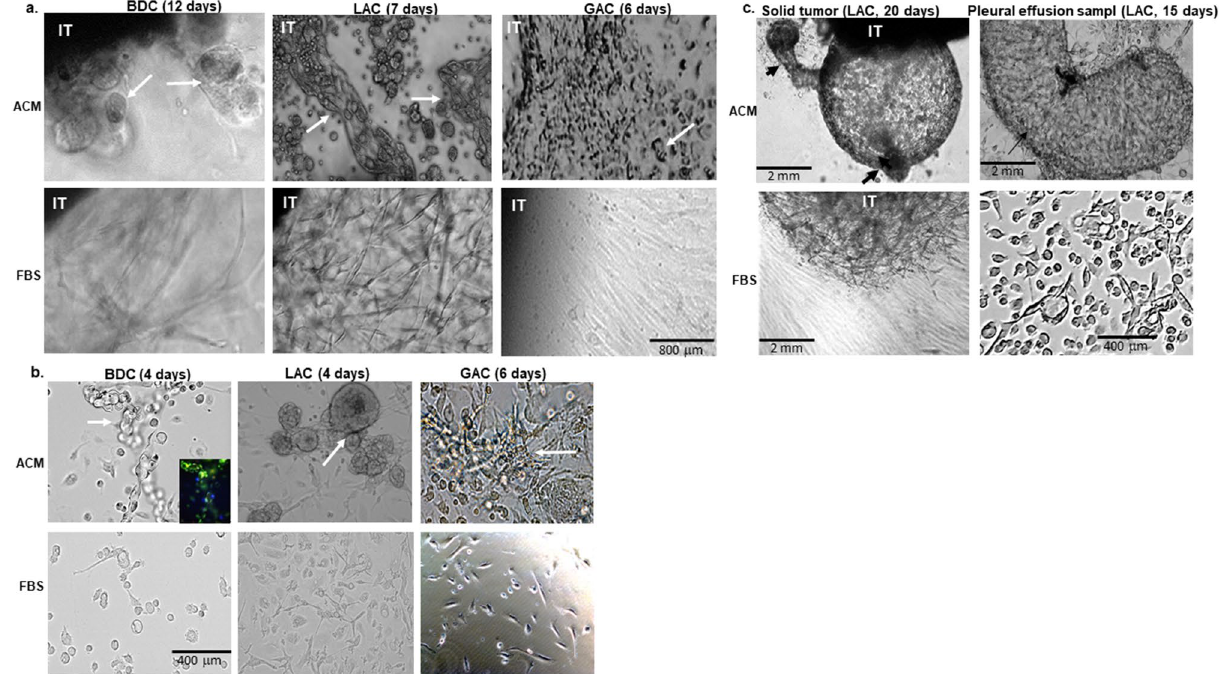
Figure 1. Differences between ACM and FBS in culture images. Breast ductal carcinoma (BDC), lung adenocarcinomas (LAC), and gastric adenocarcinoma (GAC) from ( a ) surgically removed solid tumors or ( b ) isolated from ascites/pleural effusion, were cultured with ACM (upper rows) and FBS (lower rows) side-by- side . Tissue-like structures appeared in all ACM cultures (white arrows), but not in FBS. ( c ) Masses in ACM cultures (top row) of solid LAC sample (left column) and pleural effusion LAC sample (right column) after longer culture duration (≥ 15 days); no masses in FBS. The newly formed LAC globular tumor had several new branches that budded out and formed new tumors (black arrow heads; top row on the left). IT: implanted tissue. Scale bar as